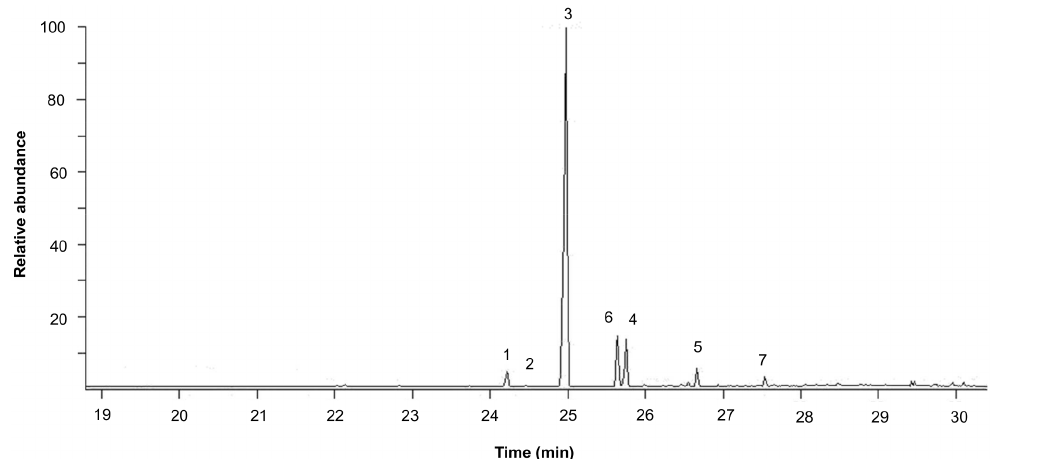
Fig. 1. Gas chromatogram of the sex pheromone components emitted by H. axyridis females. The chromatogram was obtained on the 12th day of sampling. The peaks that were associated with the pheromonal blend are numbered according to the components identified by GC-MS in S1 Table. These components were identified as b -elemene (1), methyl-eugenol (2), (–)- b -caryophyllene (3), a -humulene (4), and a -bulnesene (5). Peak 6 is (E)- b -farnesene, which was emitted by aphids, and peak 7 is an unknown compound of plant